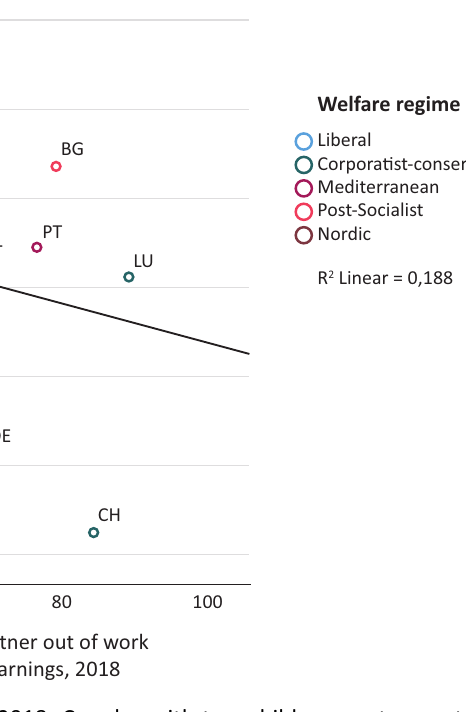
Figure 1. Net replacement and homeownership rates in Europe, 2018: Couples with two children, partner out of work (seven months), average earners (percentage in relation to previous earnings). Source: Based on Eurostat (2022b) and OECD